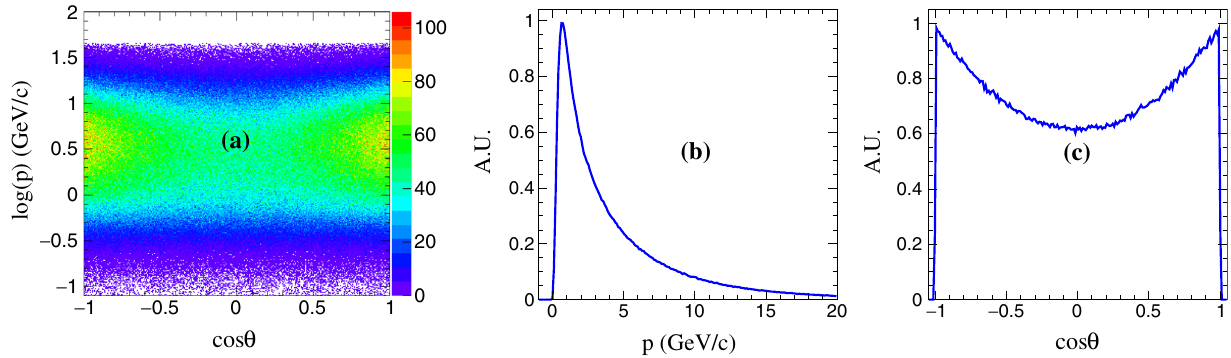
Fig. 3 Kinematic distribution of kaons in e + e − → Z → q ¯ q MC events as a function of log ( p ) and cos θ ( a ), p ( b ), and cos θ ( c )